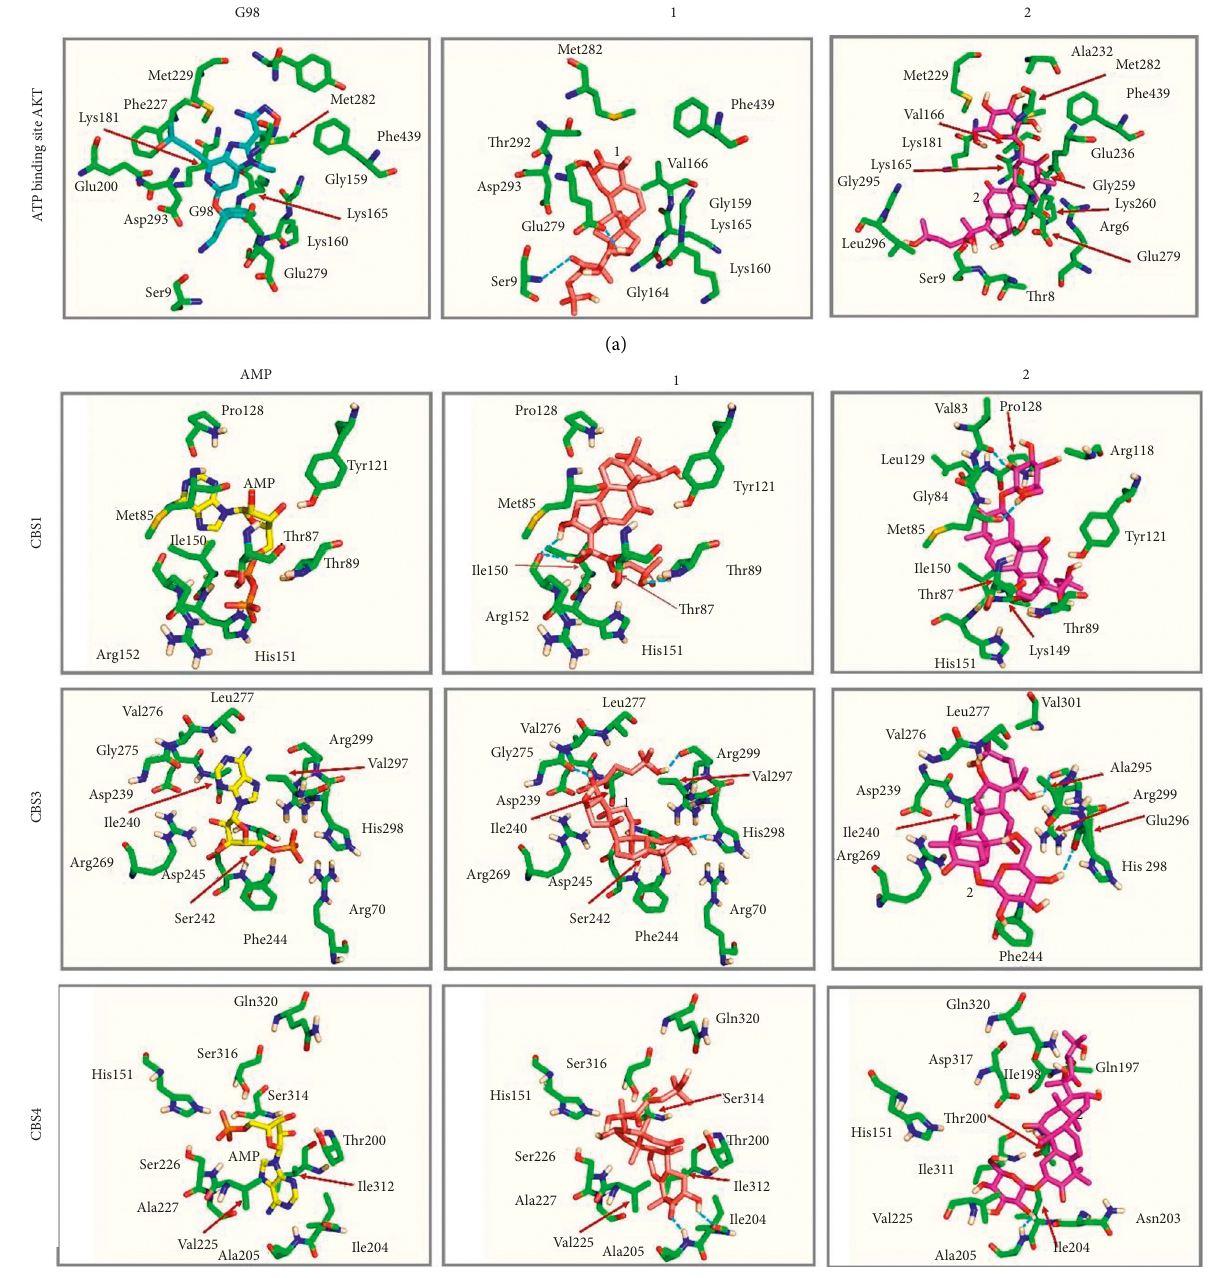
Figure 7: Binding of compounds 1 and 2 to AKTand AMPK. (a) Binding of compounds 1 and 2 to the ATP binding site of AKTshowing inhibitor G98, and compounds 1 and 2 bound. (b) Binding of compounds 1 and 2 to the cystathionine β -synthetase (CBS) sites CBS1, CBS3, and CBS4 of AMPK. Panels show the residues of the active site of the enzymes located within 4 ˚A of compounds 1 and 2. Amino acids (colored in green) and compounds 1 (colored in pink) and 2 (colored in magenta) are shown as sticks. For AKT, the inhibitor G98 is shown in cyan, while for AMPK, ADP bound to CBS1 and AMP bound to CBS3 and CBS4 are shown in yellow. H-bonds of the compounds with residues of the binding site of the enzymes are indicated by orange dashed lines. The figure was drawn with PyMOL version 2.1.0 (Schr¨odinger, LLC;